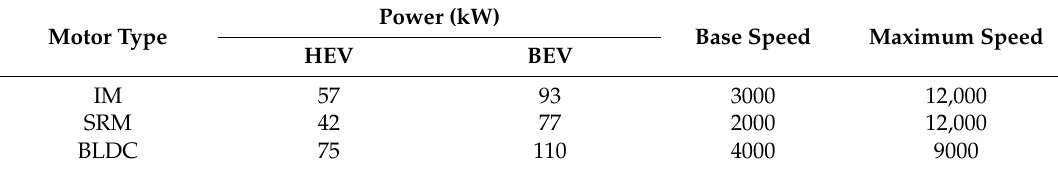
Table 15. Power comparison of different motors having the same size. Data from [72].